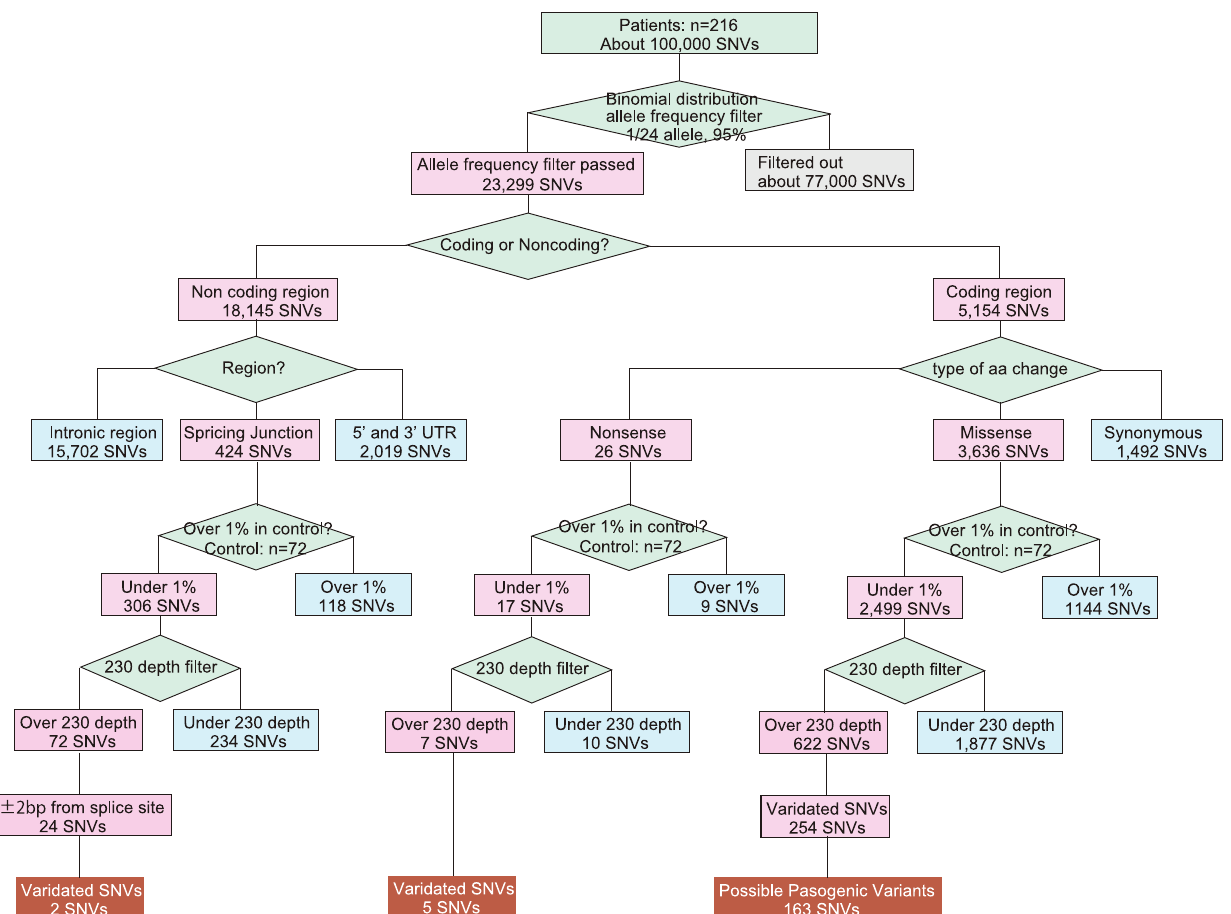
Figure 1. Algorithm applied in this study. Nonsense mutations, splice-site mutations, and missense mutations were chosen according to this algorithm.